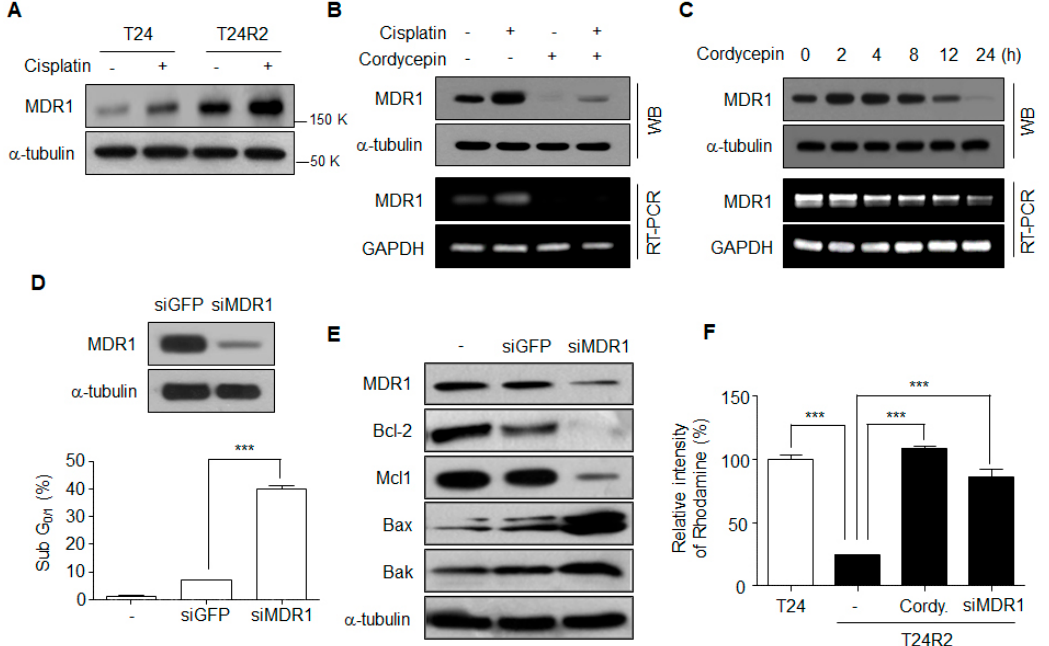
Figure 3. Cordycepin ‐ mediated downregulation of MDR1 is associated with the T24R2 cell resistance to cisplatin. ( A ) Expression of multidrug resistance protein 1 (MDR1) in T24 and T24R2 cells. ( B ) MDR1 mRNA and protein levels in T24R2 cells treated with cordycepin and / or cisplatin. GAPDH, glyceraldehyde 3 ‐ phosphate dehydrogenase; WB, western blotting; RT ‐ PCR, Reverse transcription ploymerase chain reaction. ( C ) MDR1 expression levels were analyzed after cordycepin treatment for the indicated times. ( D ) T24R2 cells were transfected with control siGFP or siMDR1 to knock down MDR1 expression. Representative flow cytometric analysis of DNA content in T24R2 cells treated with cisplatin under MDR1 knockdown (siRNA MDR1). ( E ) After transfection with MDR1 siRNA, T24R2 cells were treated for 24 h with 2 μ g/mL of cisplatin. Anti ‐ apoptotic proteins (Mcl ‐ 1 and Bcl ‐ 2) and pro ‐ apoptotic proteins (Bax and Bak) were assessed by Western blotting. ( F ) Cells were